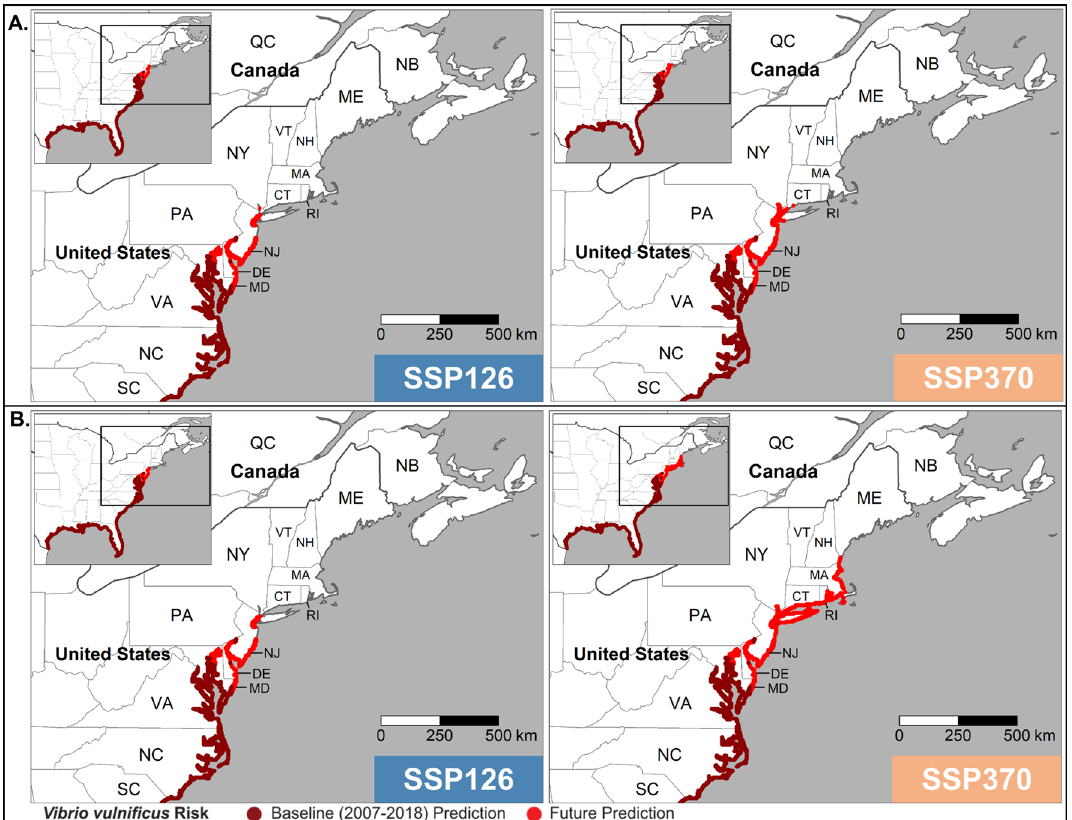
Figure 3. Baseline and projected V. vulnificus infection distribution (presence) predicted using tmean and then averaged across seven CMIP6 global climate models for ( A ) 2041–2060 and ( B ) 2081–2100 under CMIP6 SSP126 and